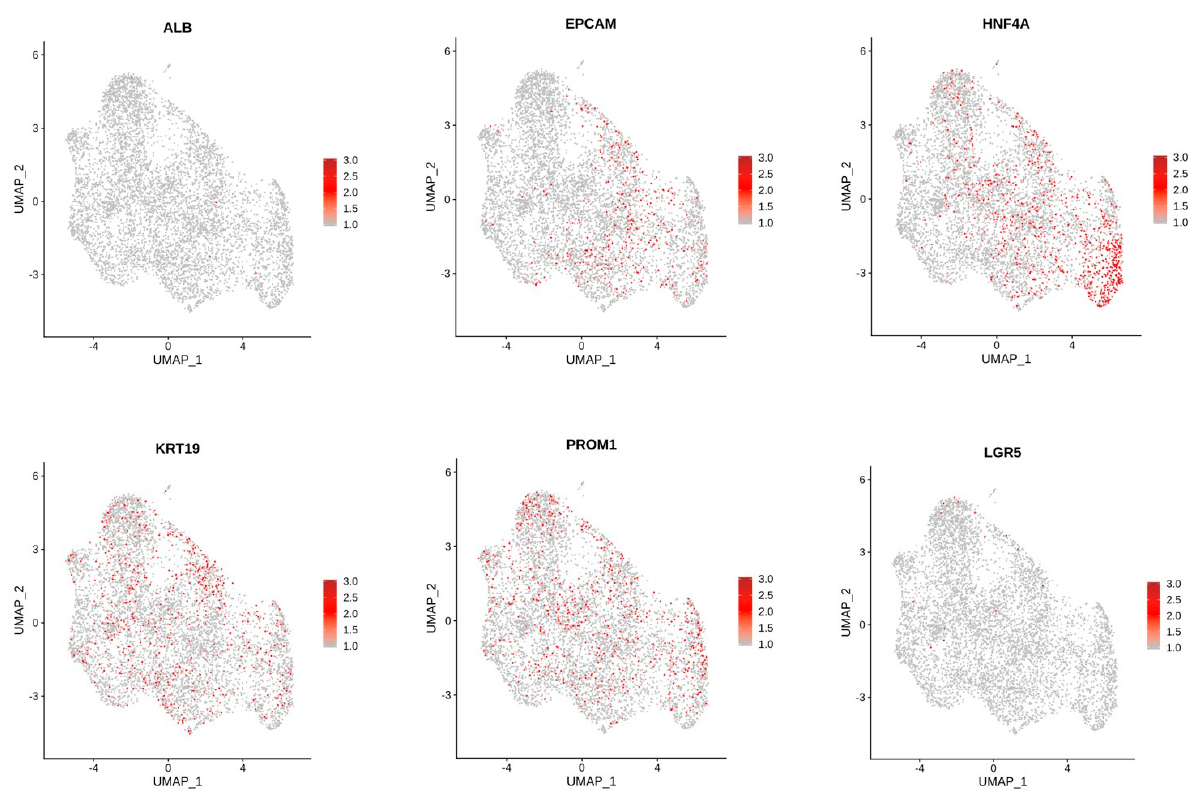
Figure 10. Feature Plots showing expression of genes of interest across cells in all